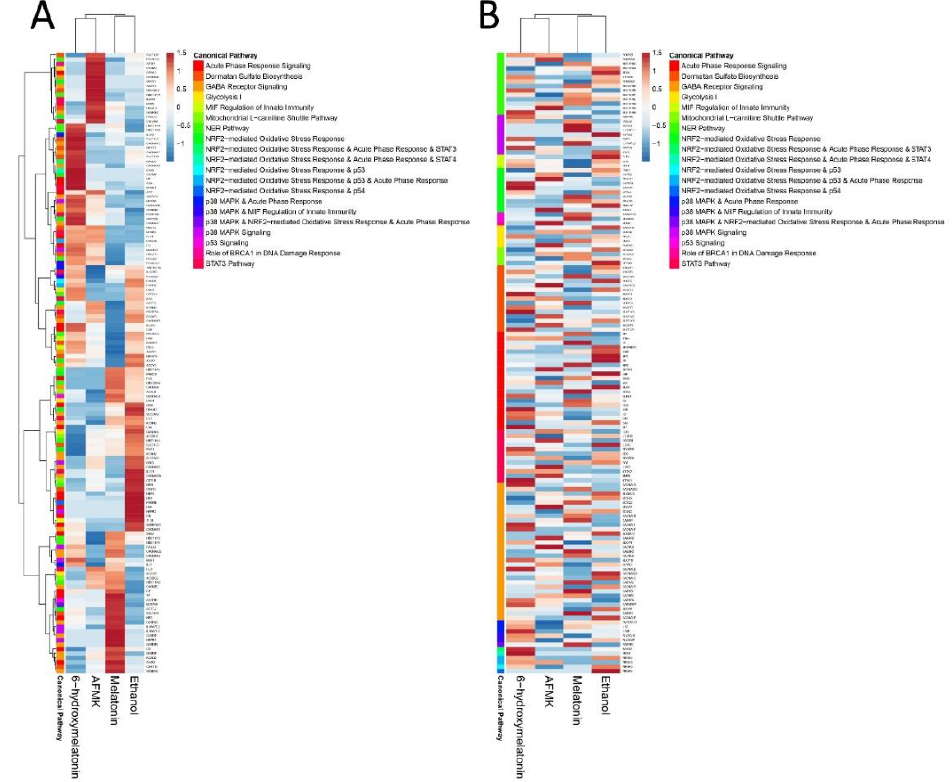
Figure 2. Heatmaps created from canonical pathways results of IPA with clustering ( A ) or without clustering ( B ) of the sets of the genes involved in enriched pathways.